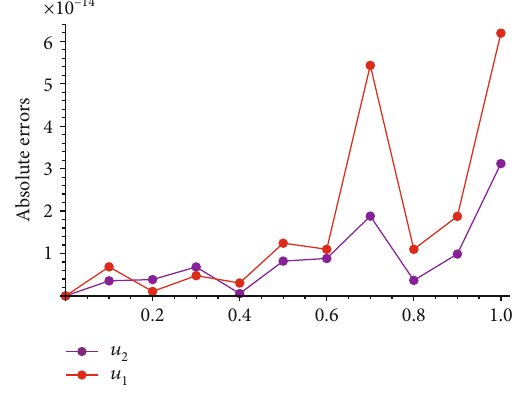
2 obtained by the present method for